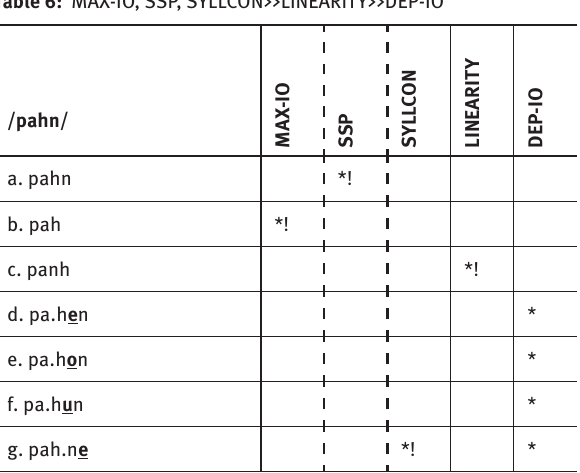
Table 6: MAX-IO, SSP, SYLLCON>>LINEARITY>>DEP-IO